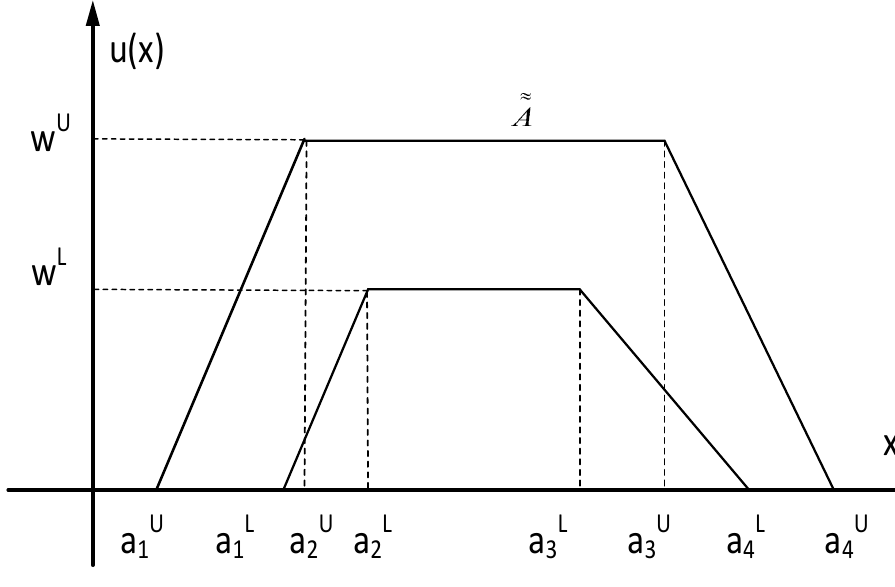
Figure 1. An interval type-2 fuzzy number (cid:101)(cid:101) A